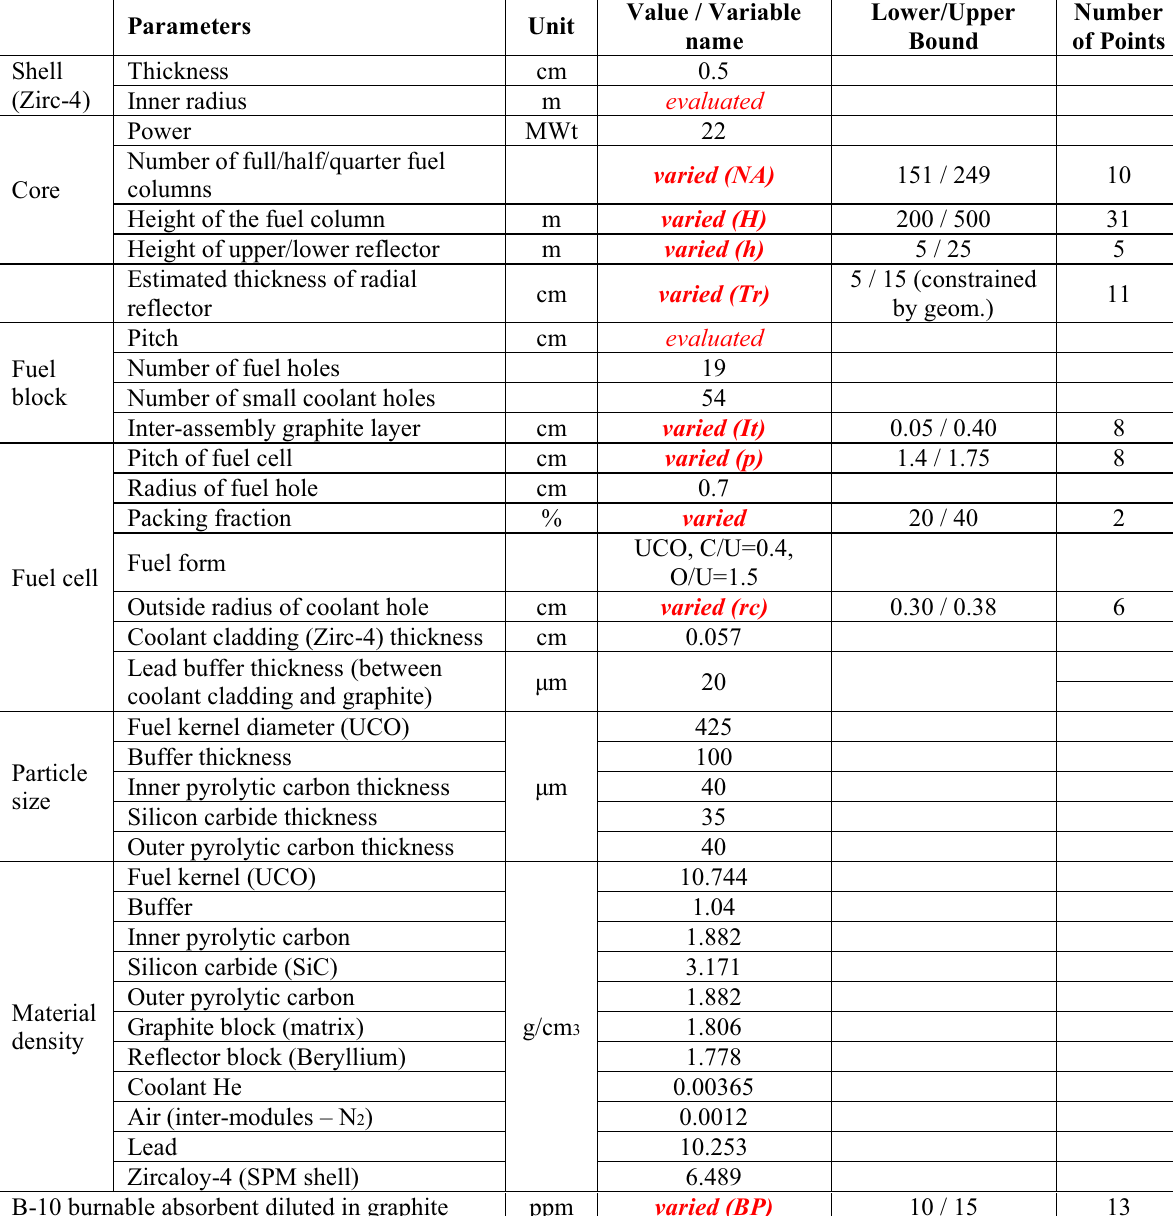
Table 1. Design parameters used for modeling the Holos-Quad core (hot